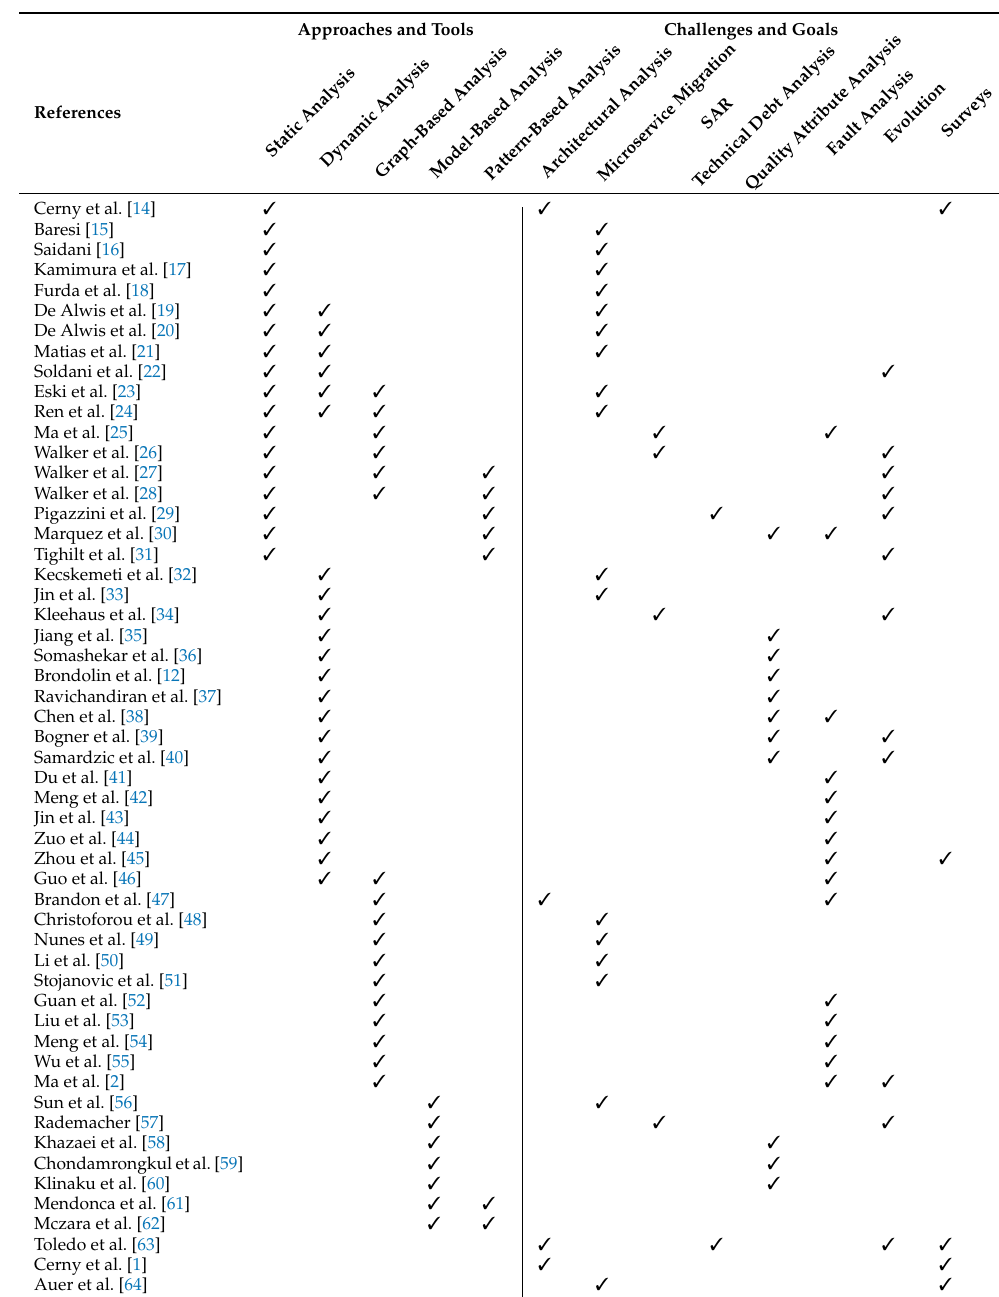
Table 3. Selected paper categorization. Approaches and Tools Challenges and